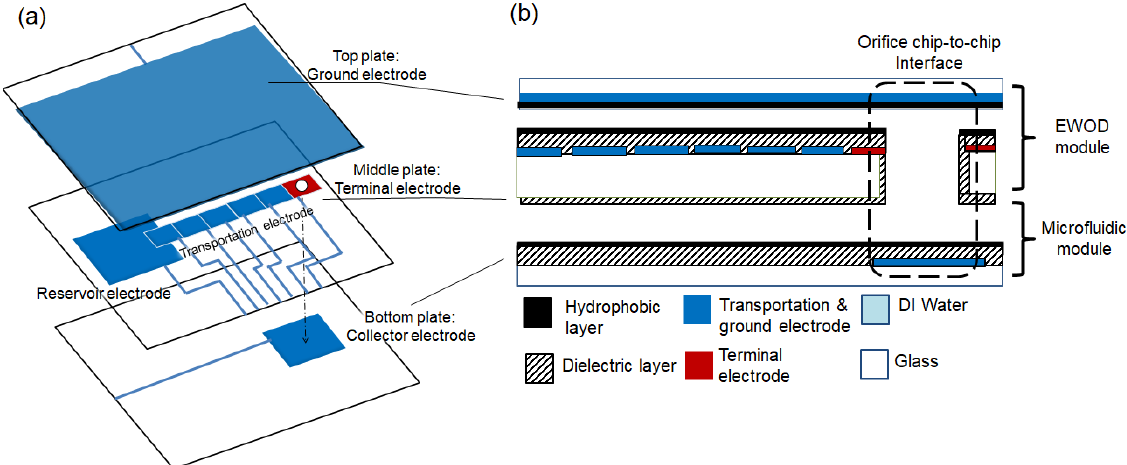
Figure 1. ( a ) 3D view and ( b ) cross-sectional view of the vertical EWOD configuration: A droplet can move vertically through the EWOD module. There are three plates: the top and middle plates form an EWOD module, while the bottom plate represents an external device. The top plate has ground electrodes. The middle plate has an array of electrodes with an orifice where the droplet can pass through. The bottom plate has a patterned electrode aligned to the orifice.